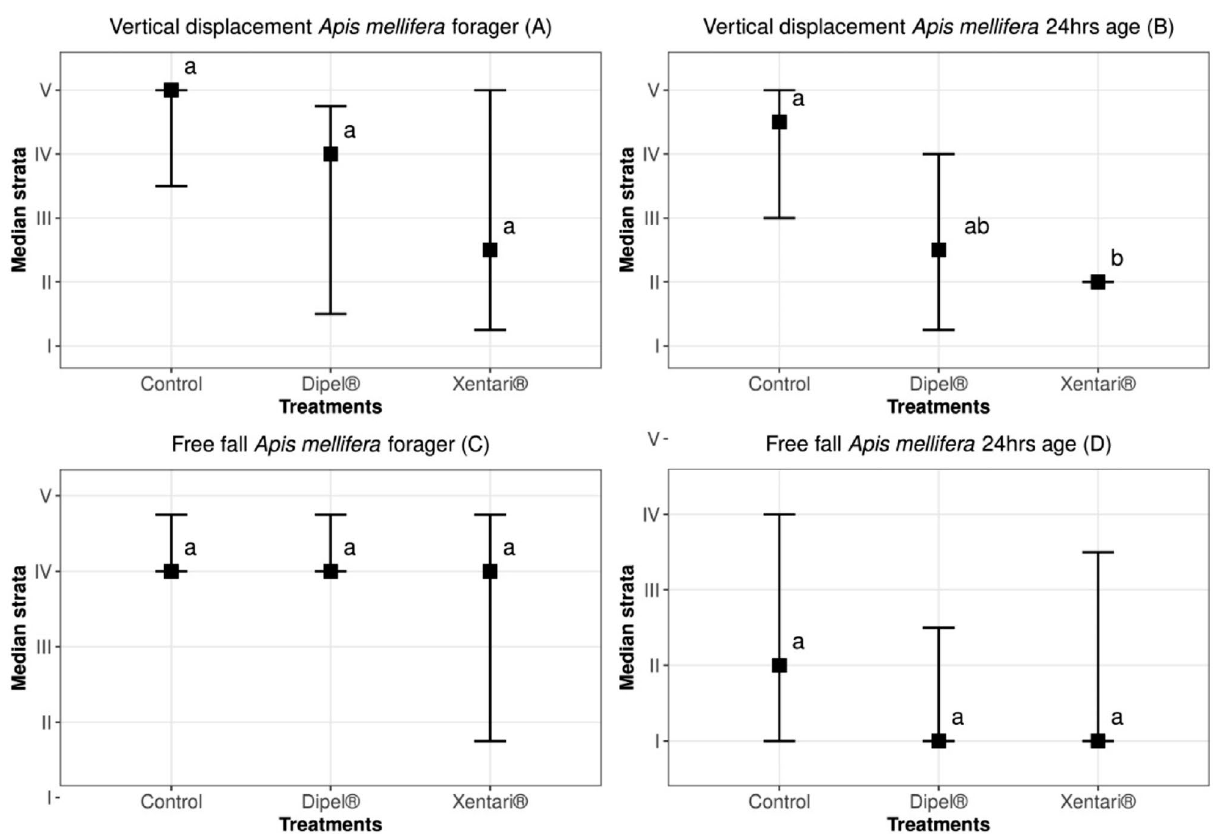
Figure 3. Vertical displacement ( A , B ) and free fall ( C , D ) of foragers and newly emerged (24-h-old) worker bees ( Apis mellifera ), 144 h after ingestion of Candi paste incorporating the indicated treatments. The squares represent the median strata values for each treatment with the respective first and third quartiles. The same lowercase letters within the figures indicate that there was no significant difference between treatments ( p < 0.05) for the multiples comparison Tukey test.